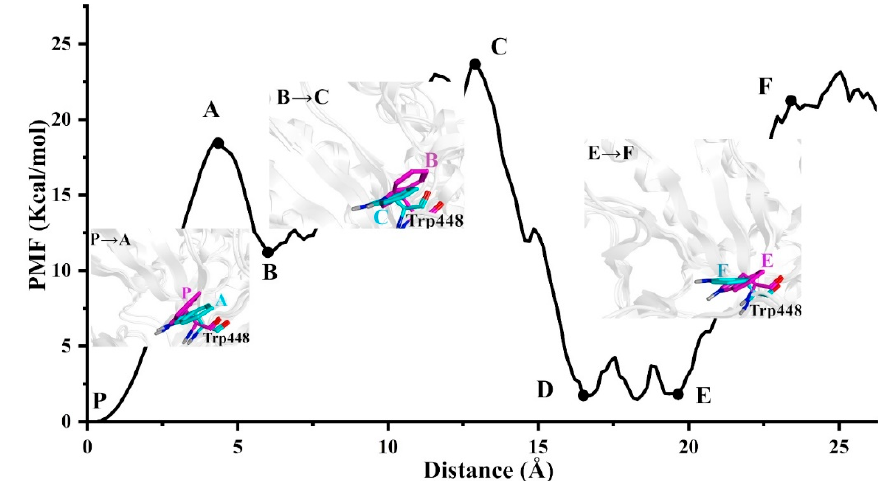
Figure 8. Structural features of Trp448 along the most possible unbinding route.